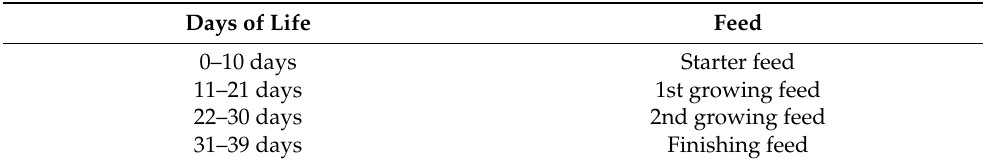
Table 2. Animal feeding conditions during the in vivo trial.